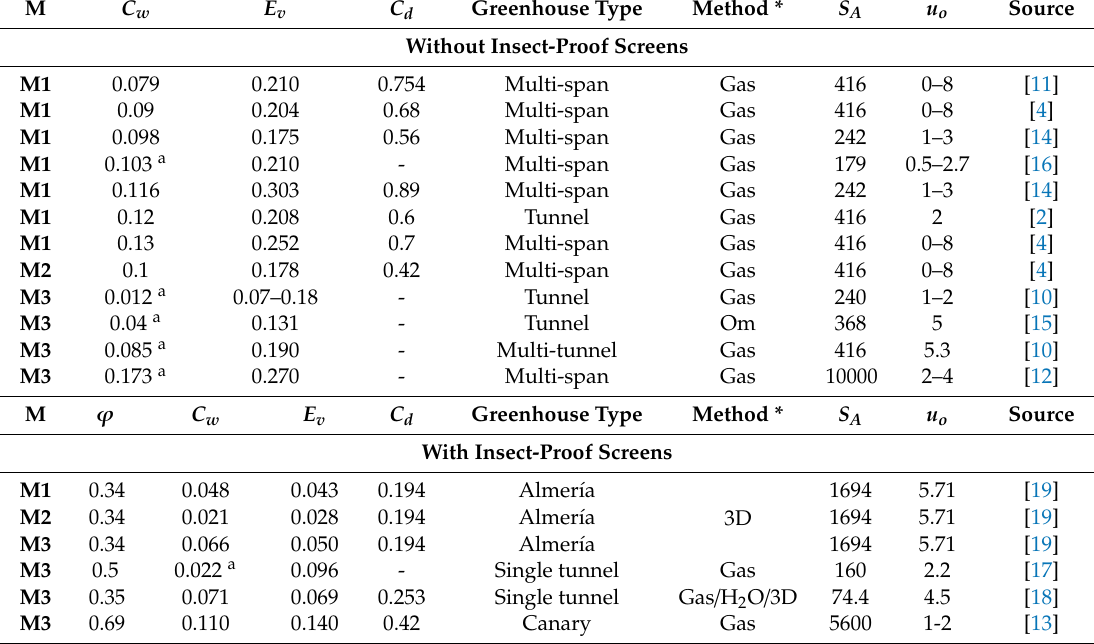
Table 7. Values of the wind e ff ect coe ffi cient C w , discharge coe ffi cient of the openings C d , coe ffi cient of e ff ectiveness of the openings E v = C d C w0.5 obtained by di ff erent authors in di ff erent types of greenhouses with side and roof vents, with and without insect-proof screens (all values are taken from Molina-Aiz et al. [19]). S A , greenhouse base surface area [m 2 ]; u o , air velocity [m s − 1 ]; M, model